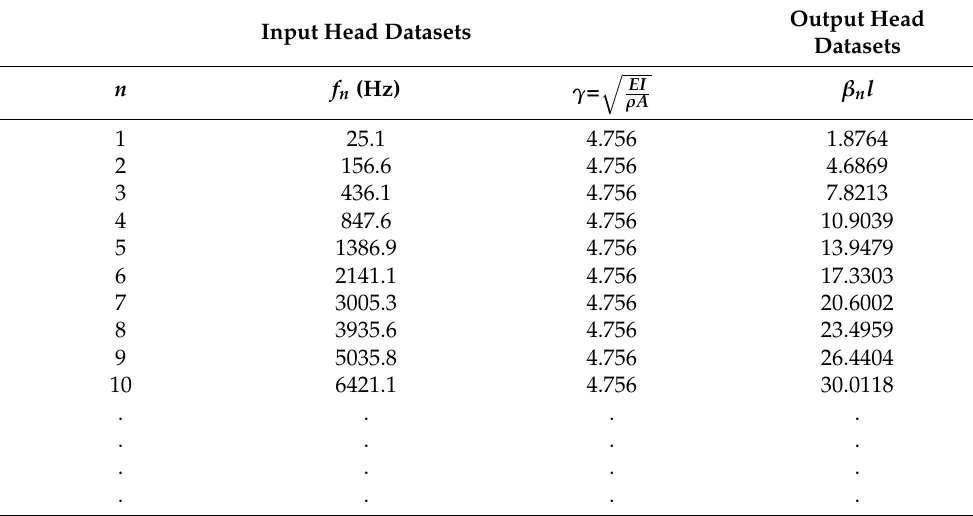
Table 2. Input and output head datasets for training the LSTM-RNN network for approximating transcendental